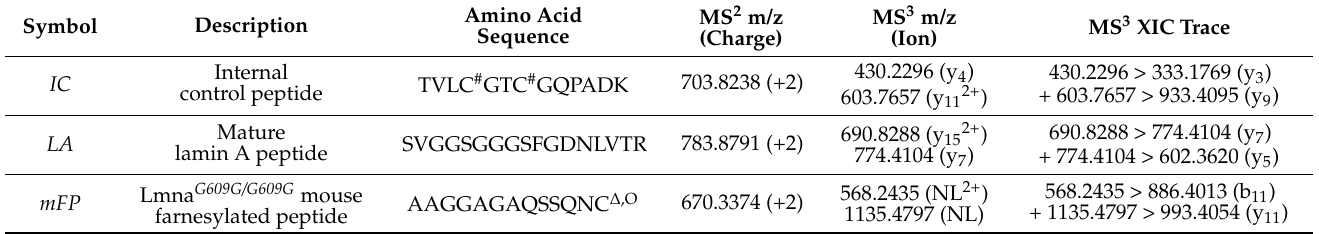
Table 1. Precursor and fragment ions traced in the targeted PRM LC-MS/MS analysis of Lmna G609G/G609G mouse